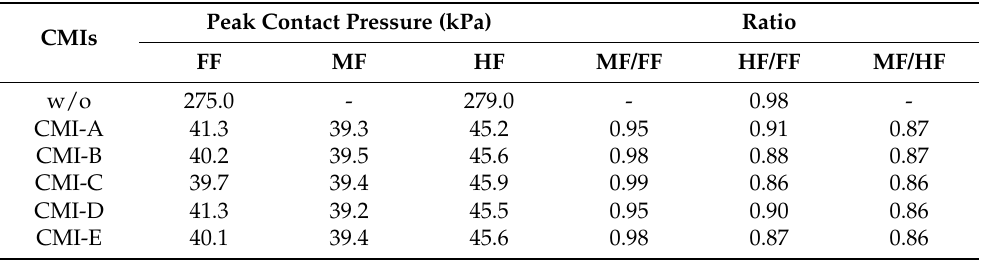
Table 3. Peak contact pressure without and with CMI fabricated from various materials and their combinations.